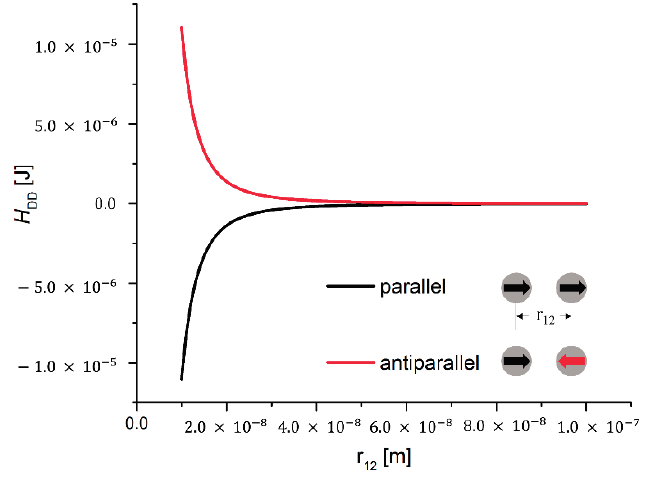
Figure 1. Magnetic dipole-dipole energy curves for the case of two interacting cobalt particles with diameters of 10 nm. The magnetic dipole-dipole energy is plotted vs. the center-to-center distance of the particles. For the case of particles with magnetic moments aligned in parallel, negative energy values are obtained (black curve), resulting in particle attraction. In contrast to this, for an antiparallel alignment of the magnetic moments, positive energy values are obtained (red curve), resulting in particle repulsion. It becomes apparent that the magnetic dipole-dipole potential contribution cannot be cut off due to its long-range character over a distance of several particle diameters even for small